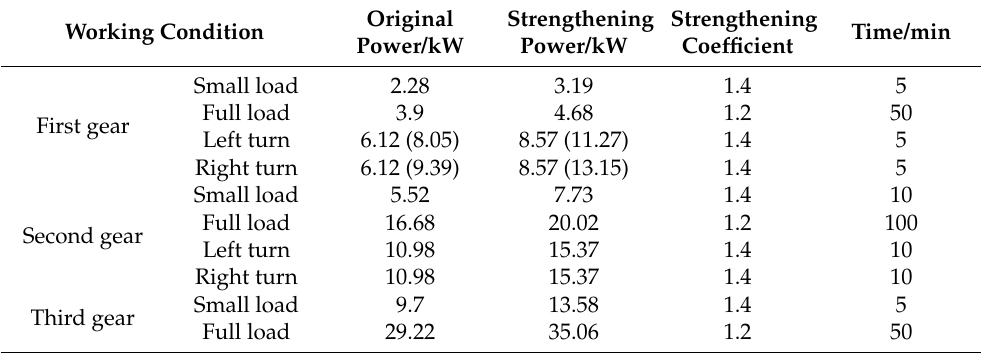
Table 7. Peak power of two steering modes in first gear and second gear: the forward working condition is uniformly used to carry a larger load of the right walking half shaft; the steering condition is unilateral braking steering in (), and the rest is differential steering; the time column takes the first shift time as an example, which is divided according to the running time of each gear. Original Working Condition Power/kW